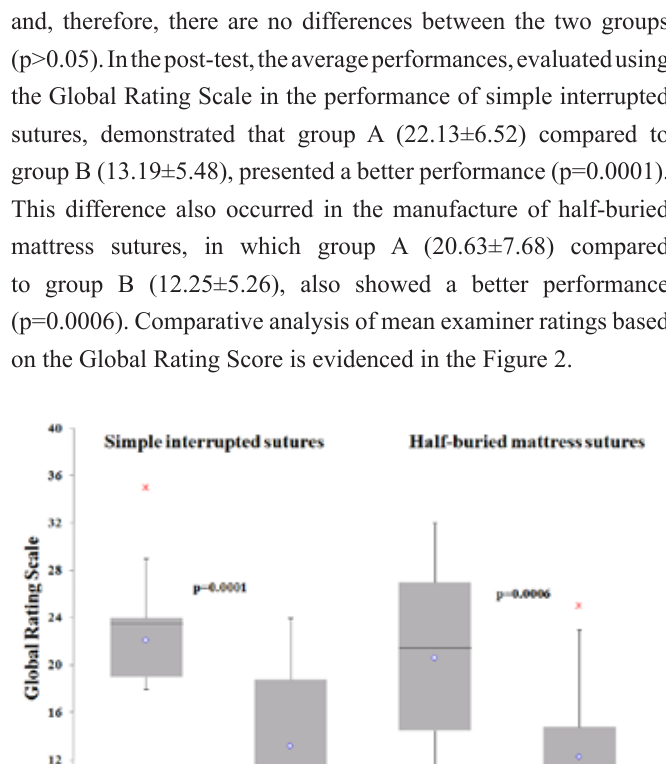
TABLE 2 - Comparative analysis of number of students that performed stitches and of number of stitches done by each group in the post-test. FIGURE 2 – Comparative analysis between all suture performances based on the Global Rating Scale of the both groups A (ethylene-vinyl acetate bench model) and B (control) for both types of stitches performed in the post-test. The heavy line is the median. The bars represent the range of the data. The symbols “*” indicate the